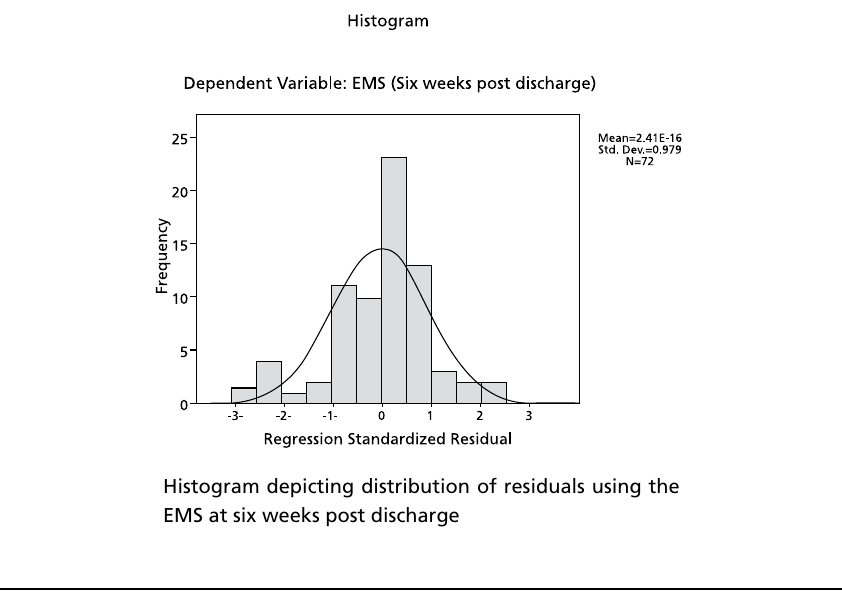
Figure 4: histogram depicting the distribution of variables using the elderly Mobility scale at six weeks post discharge